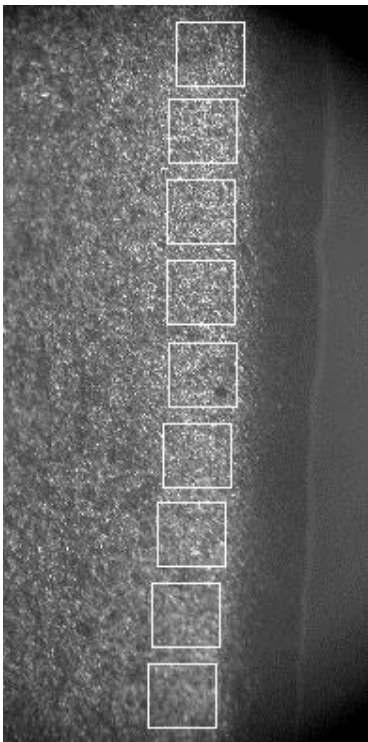
Figure 7: Processing frame surface sampling